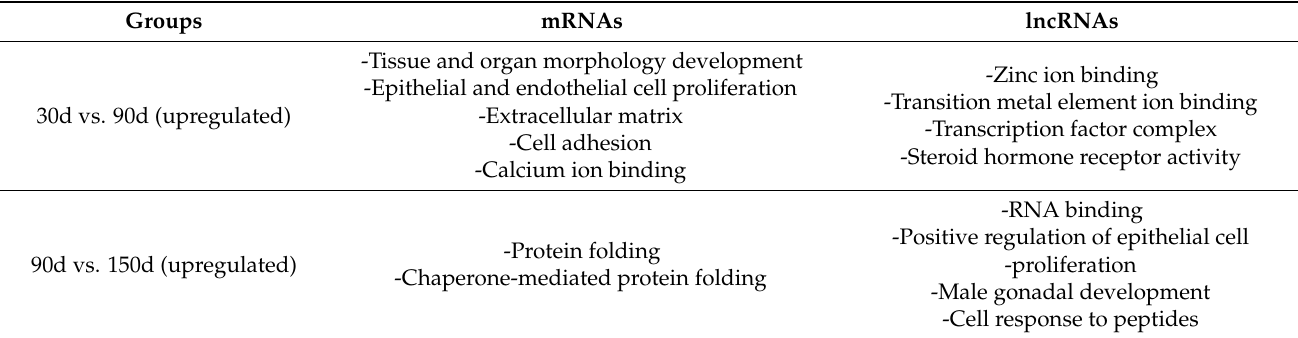
Table 3. Go enrichment analysis of mRNAs in consecutive groups (30d vs. 90d, 90d vs. 150d, and 150d vs. 210d).